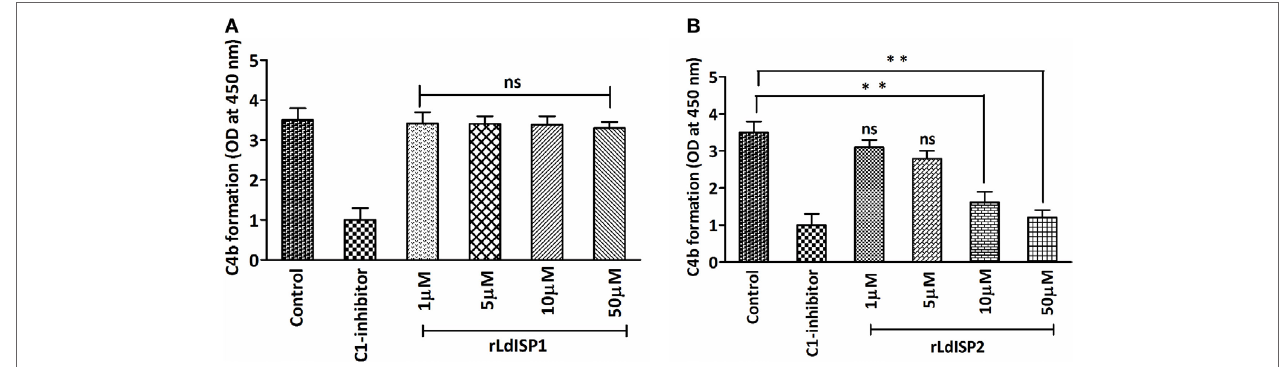
FigUre 4 | L. donovani Inhibitor of Serine Peptidases 2 (LdISP2) inhibits lectin pathway mediated C4b formation. Inhibitory effect of rLdISP1 (a) and rLdISP2 (B) on MBL-associated serine proteases (MASPs) was assessed by sandwich ELISA. Mannan-coated microtitration plate was incubated with normal human serum (1/10 v/v), NHS pretreated with C1-inhibitor and rLdISP1/rLdISP2 (0–50 µM). The ELISA plate bound with serum-derived MASPs was used as a control. Purified C4 molecule (0.2 µg/ml) was added to the plate and incubated for 2 h at 37°C. C4 cleavage was monitored by the relative formation of C4b molecule after addition